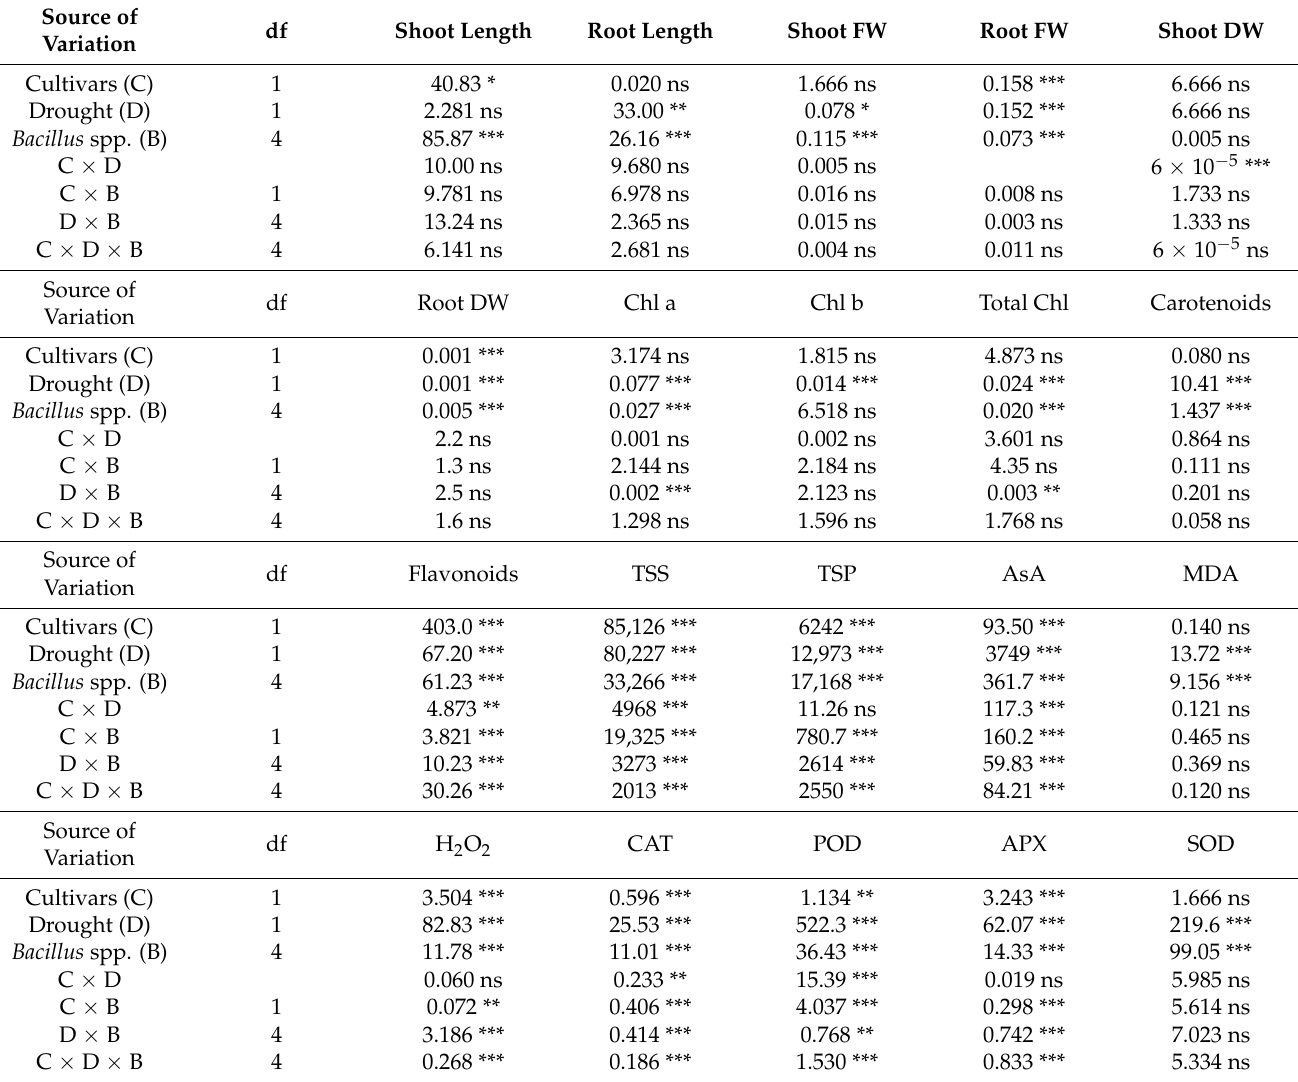
Table 3. Mean squares from three-way analysis of variance of data for different physiological, biochemical and antioxidant parameters of maize ( Zea mays L.) plants inoculated with Bacillus spp. strains under well-watered (control, 15–18% water content in soil) and water deficit (stress, 5–8% water content in soil)